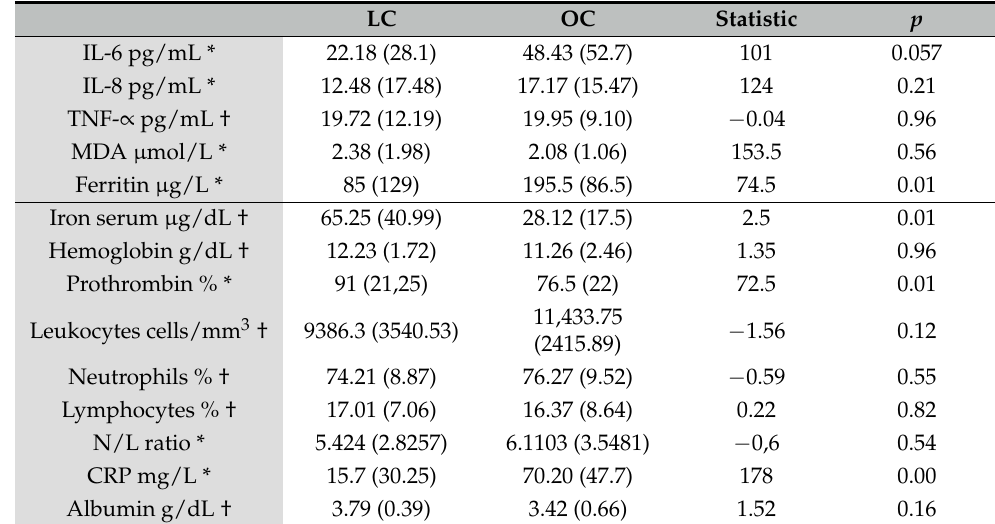
Statistic: (*) interquartile range and U; (†) standard deviation and